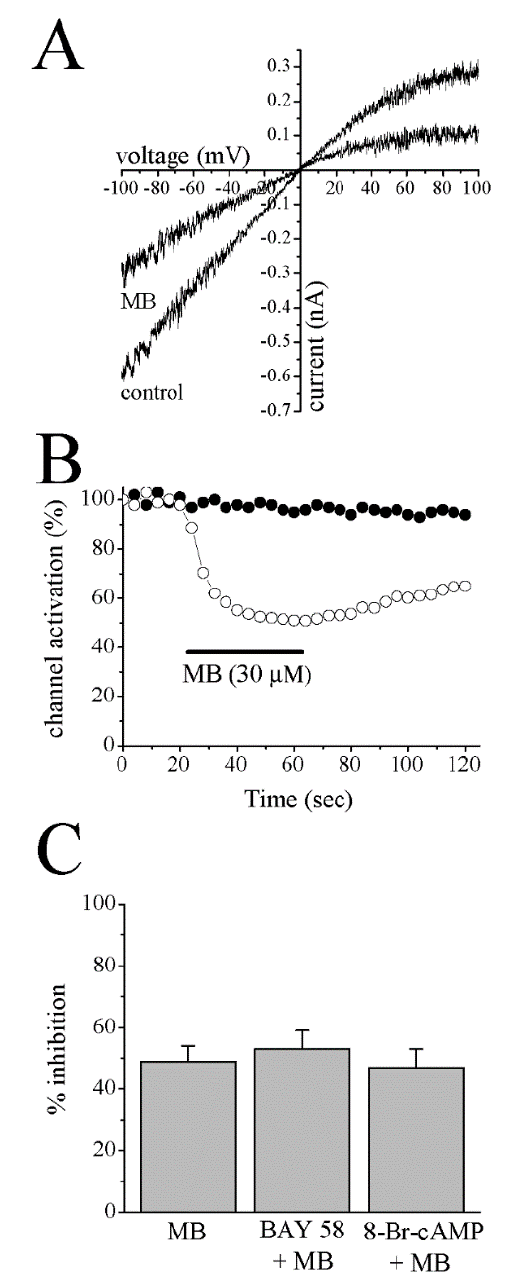
Figure 4. Effects of MB on K + currents mediated through the C-terminally deleted Kir6.2 channels (Kir ∆ C26) and the effects of cGMP modulating agents on MB inhibition of cromakalim-activated K + currents. ( A ) Currents from inside-out patches in response to two s-voltage-ramps from –100 to +100 mV under symmetric conditions (140 mM K + ) were recorded in the absence and presence of 30 µ M MB. Leak currents, recorded in the presence of 10 mM ATP, were subtracted. ( B ) Time-course of the effect of 30 µ M MB on K + currents mediated through the C-terminally deleted Kir6.2 channels (Kir ∆ C26) in the absence (filled circles) and presence (open circles) of MB (30 µ M), respectively. The horizontal bar represents the administration time of MB. ( C ) The effects of 20 min preincubation with BAY 58–2667 (3 µ M) and 8-Br-cGMP (100 µ M) on inhibition of cromakalim (100 µ M)-activated K + currents by MB (30 µ M) in follicle-enclosed oocytes ( p > 0.05, n = 5–7, Student’s t -test). MB: methylene blue; Bay 58: BAY 58 – 2667.